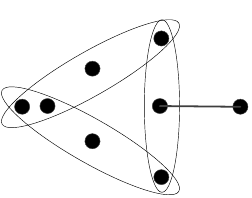
Figure 3. A generalized hypertree GHT : ω ( GHT − E ) = 2 for all any edge E